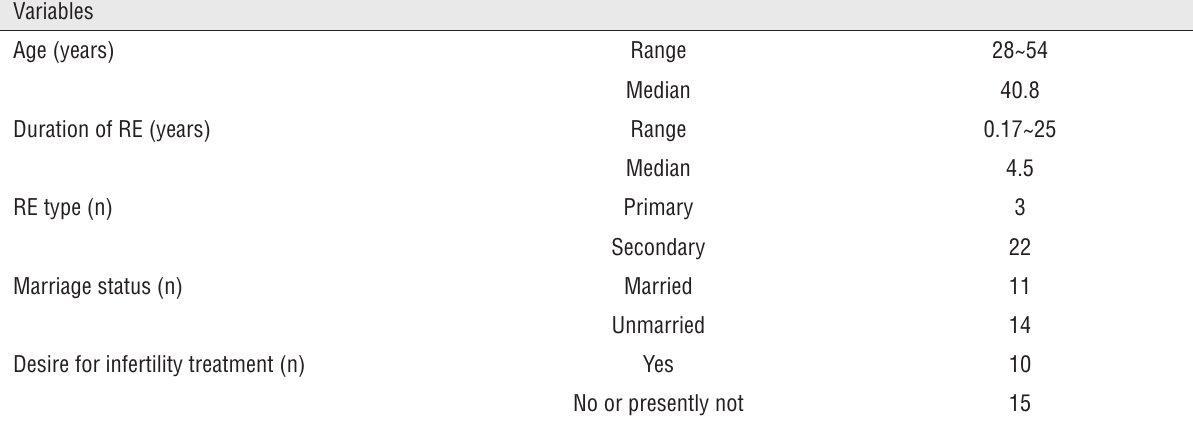
Table 1 - Demographic characteristics of the patients (n =